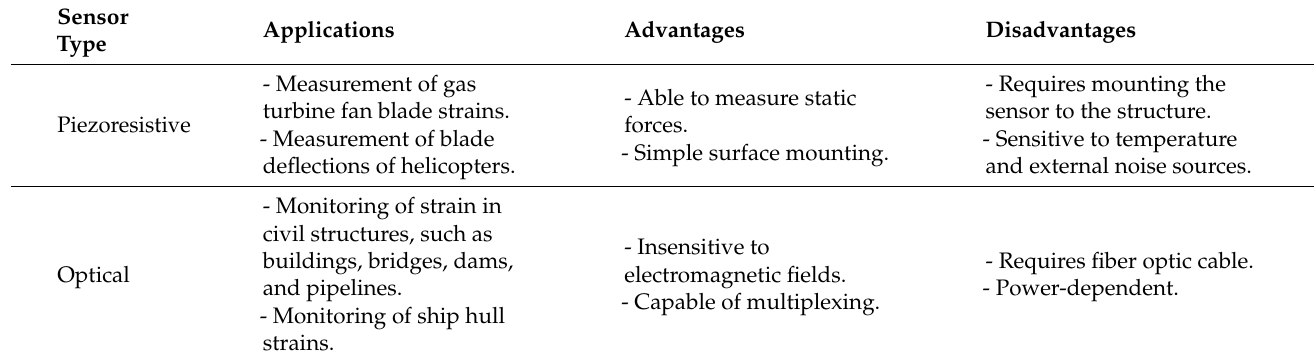
Table 21. Strain